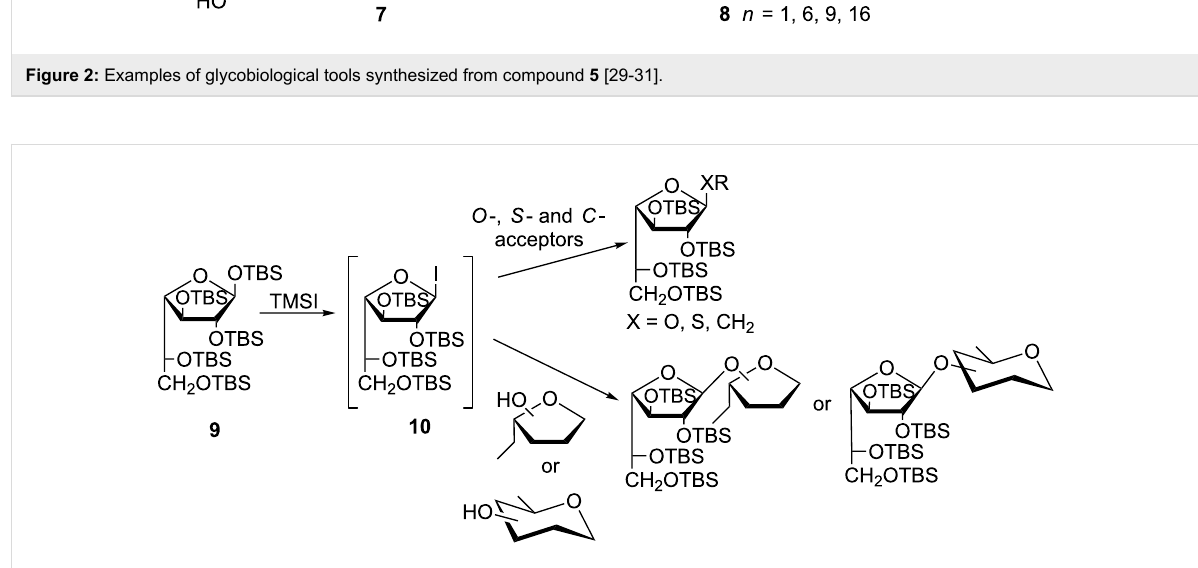
Scheme 2: D-Galactofuranosylation by the glycosyl iodide method